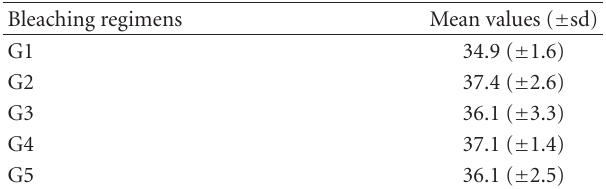
Table 4: Mean values and standard deviation ( ± sd) for VHN (after